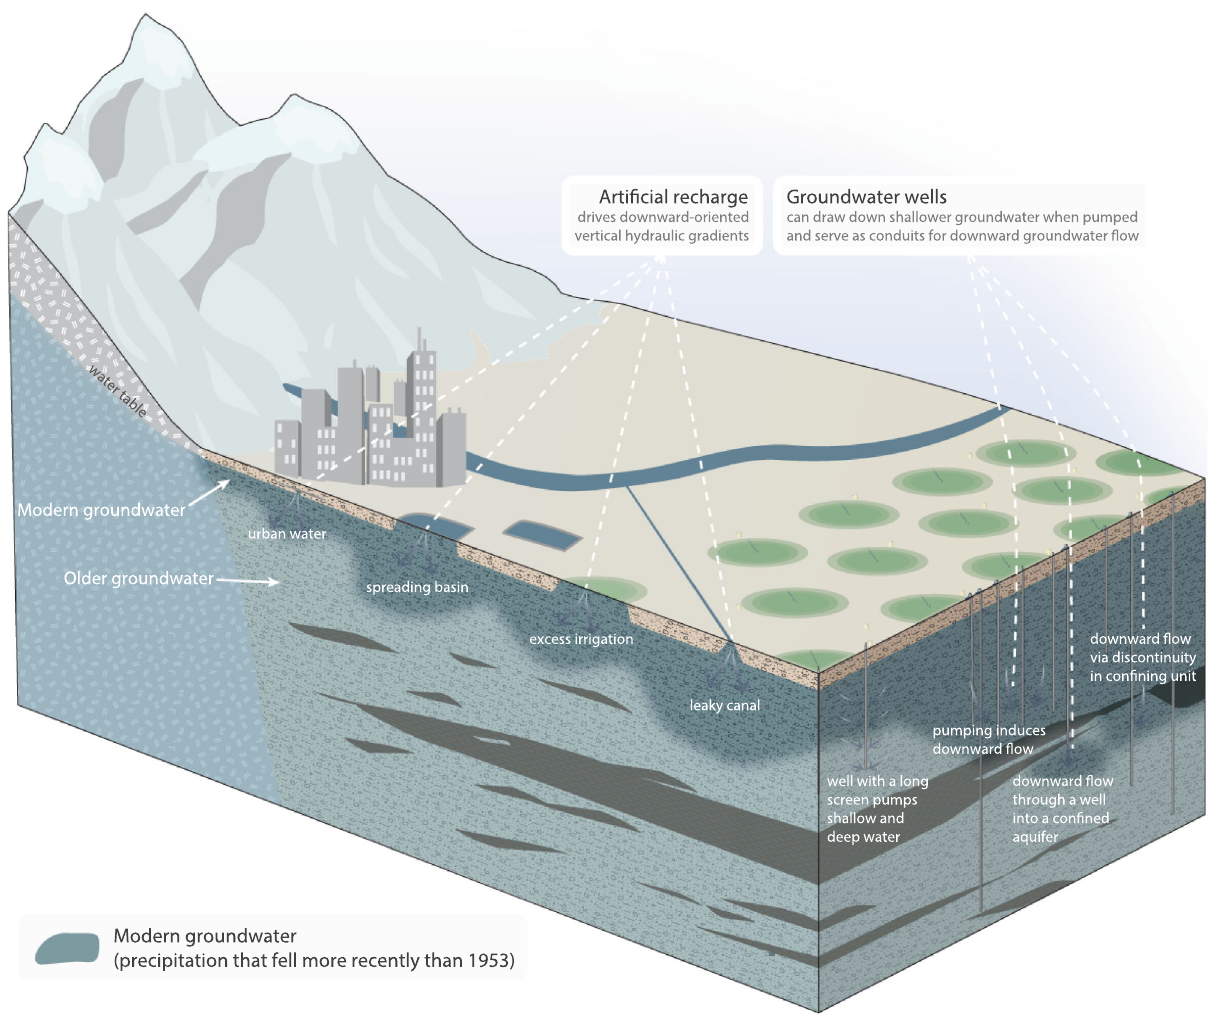
Fig. 4 | Schematic of some of the processes that may in fl uence vertical dis- tributions of modern groundwater. Arti fi cial groundwater recharge (left side of schematic) can increase the magnitude of downward-oriented vertical hydraulic gradients and potentially drive modern groundwater to deeper depths. Arti fi cial recharge can derive from urban waters (e.g., Tucson Basin 63 ), spreading basins associated withmanagedaquifer recharge projects (e.g., UpperSantaAnaBasin 64 ), excess irrigation waters (e.g., San Joaquin Basin 65 ), or leaky surface water con- veyanceinfrastructuresuchascanals(e.g.,UtahLakeValley 66 ).Theconstructionof groundwater wells and their use via pumping (right side of schematic) may help modern waters enter deeper wells. For example, deep wells that have long